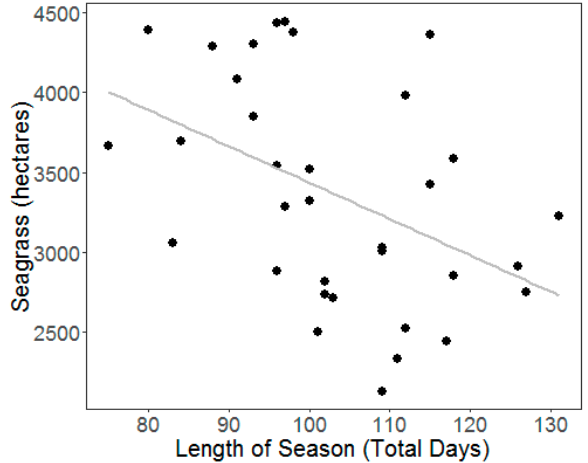
Figure 5. Linear relationship between the length of the previous summer stressful season and seagrass coverage (hectares). Seagrass hectares were calculated from the VIMS annual aerial mapping survey. Only years where data for both seagrass coverage and the length of the season were available are included. y = − 22x + 5706; p < 0.01; r 2 =